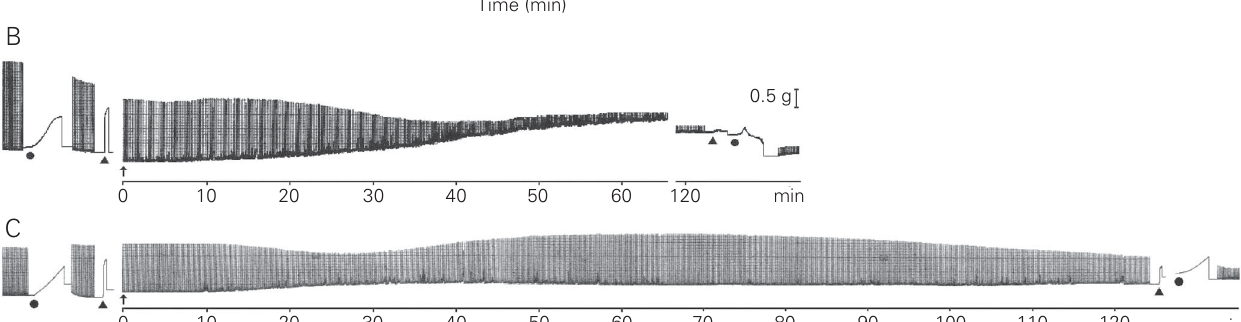
tively.Figure 4. Effect of Bothrops neuwiedii pauloensis venom (50 µg/ml) on chick biventer cervicis preparations at 20-24 (cid:1) C compared to 37 (cid:1) C. A , Concentration-time response curves for the neuromuscular blocking activity of the venom compared to Krebs solution alone (control) are shown. Each point represents the mean ± SEM of 3-6 experiments. B , Venom-treated preparations (50 µg/ml) at 37 (cid:1) C. C , A low incubation temperature (20-24 (cid:1) C) prevented the neuromuscular action of the venom (50 µg/ml). B.n. pauloensis venom was added (arrow) after allowing the preparations to stabilize for 15 min. The responses to exogenous 110 µM acetylcholine (triangles) and 13.4 mM KCl (circles) were obtained before and after the addition of venom. These results are representative of 3-4 experiments. *P<0.05 compared to the control preparations (Student